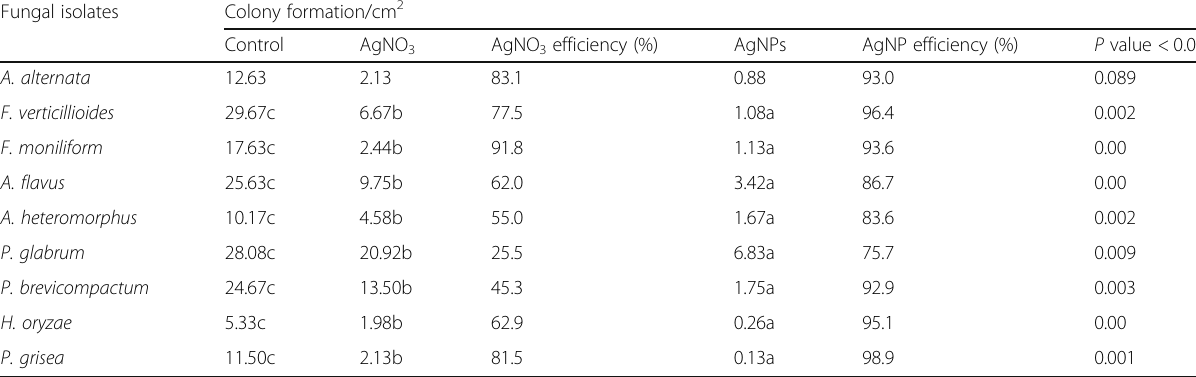
Table 1 Inhibitory effect of synthesized AgNPs by Trichoderma longibrachiatum for different fungi Fungal